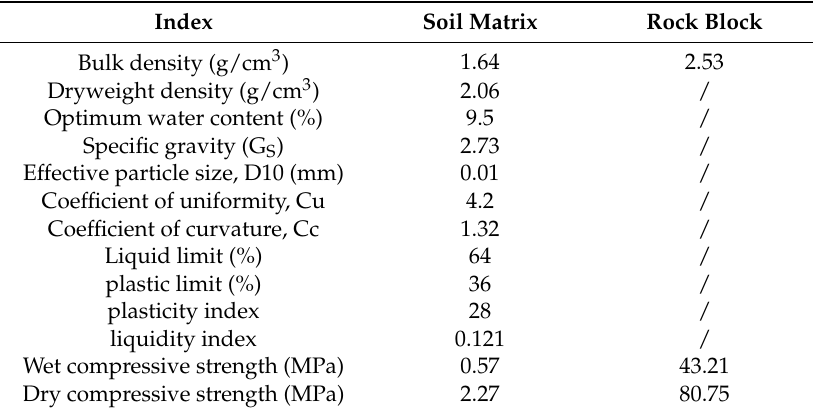
Figure 5. SEM (scanning electron microscope) results for soil Matrix 1 and Matrix 2 used for the